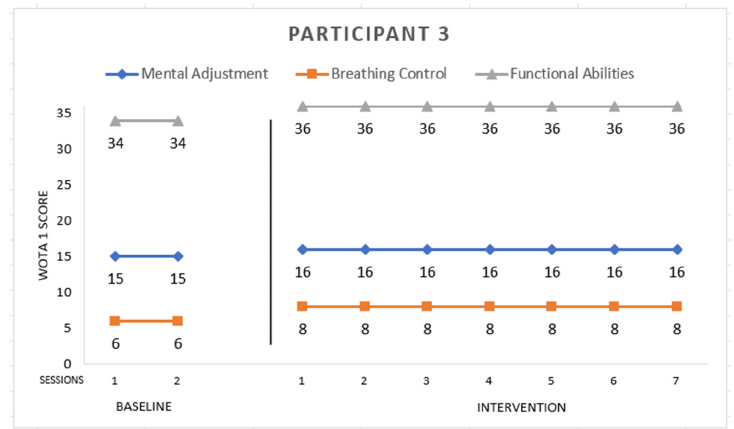
Figure 3. Highest possible scores: Mental Adjustment = 16, Breathing Control = 8, Functional Abilities = 36.